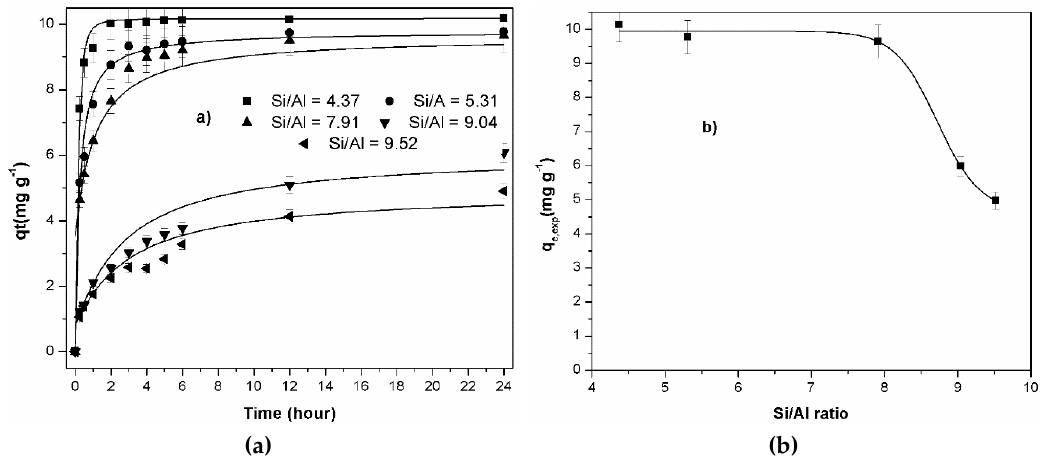
Figure 5. ( a ) Pb(II) uptake of vs. time and ( b ) experimental Pb(II) uptake vs. Si/Al ratio.